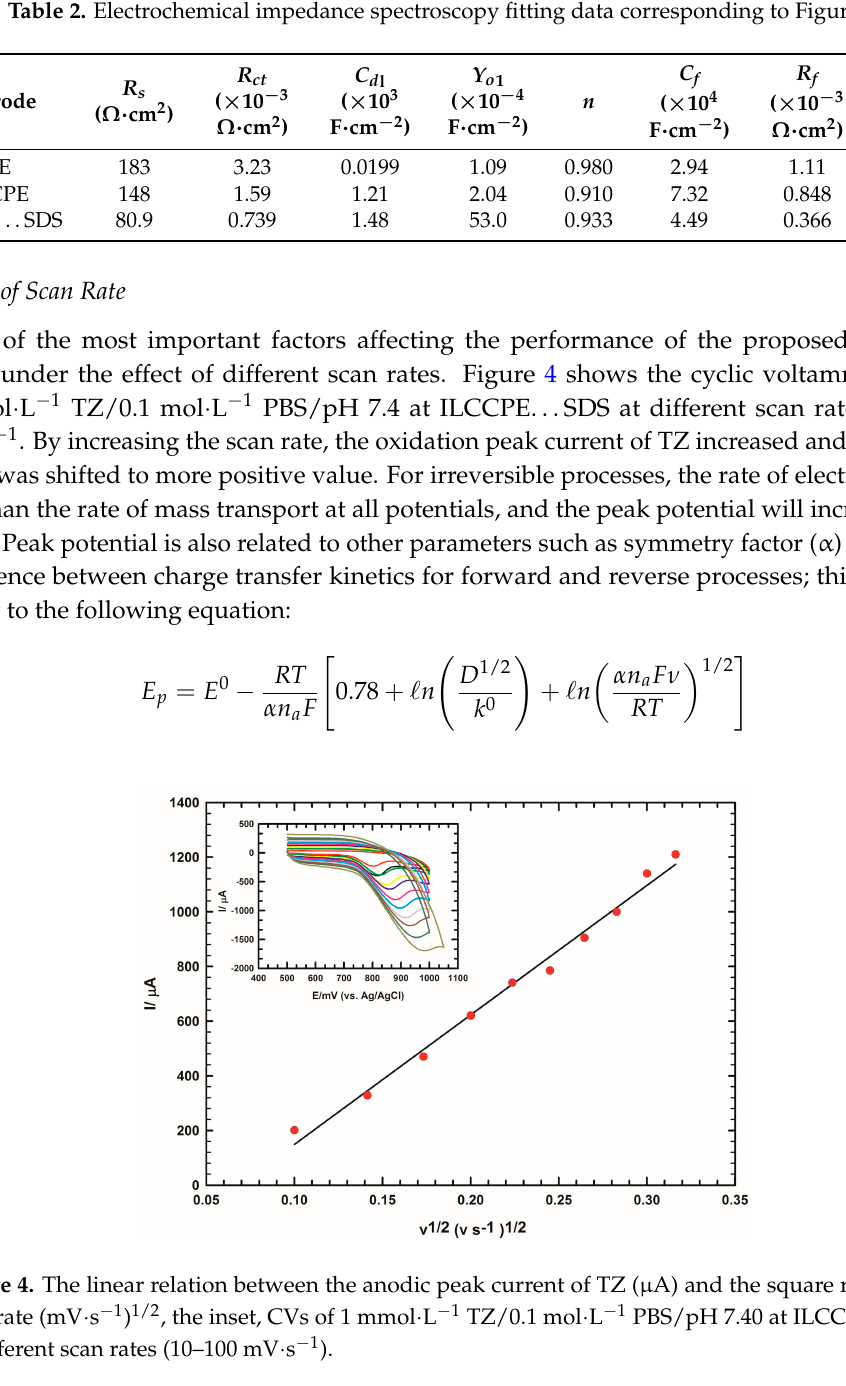
Table 2. Electrochemical impedance spectroscopy fitting data corresponding to Figure 3. Electrode